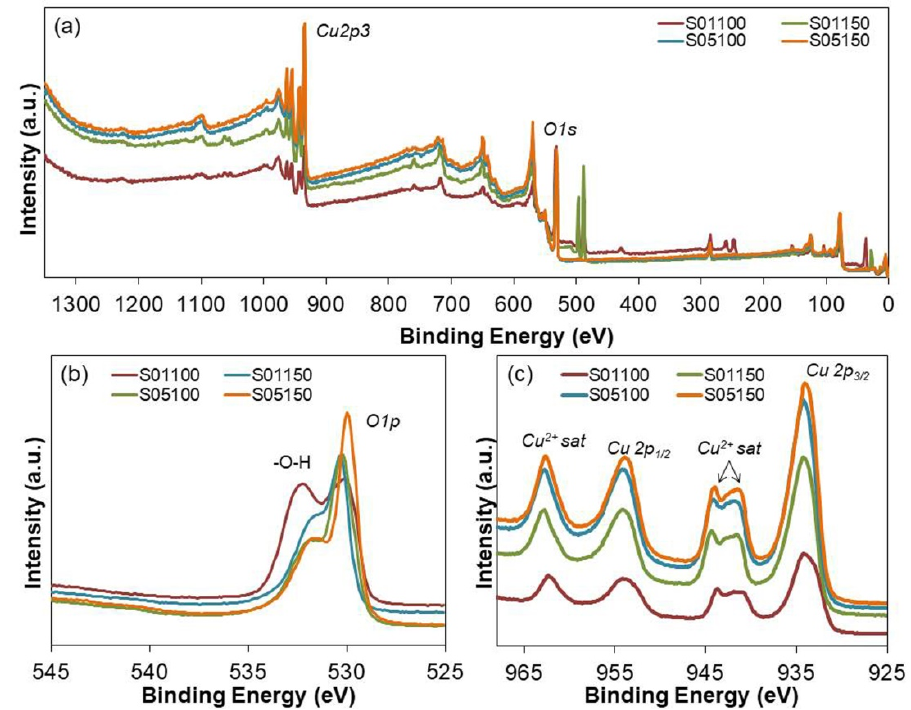
Figure 4. ( a ) The survey scan XPS spectra of CuO thin films; ( b ) the high-resolution XPS of O1s ; ( c ) the high-resolution XPS of Cu2p. ( c ) the high-resolution XPS of